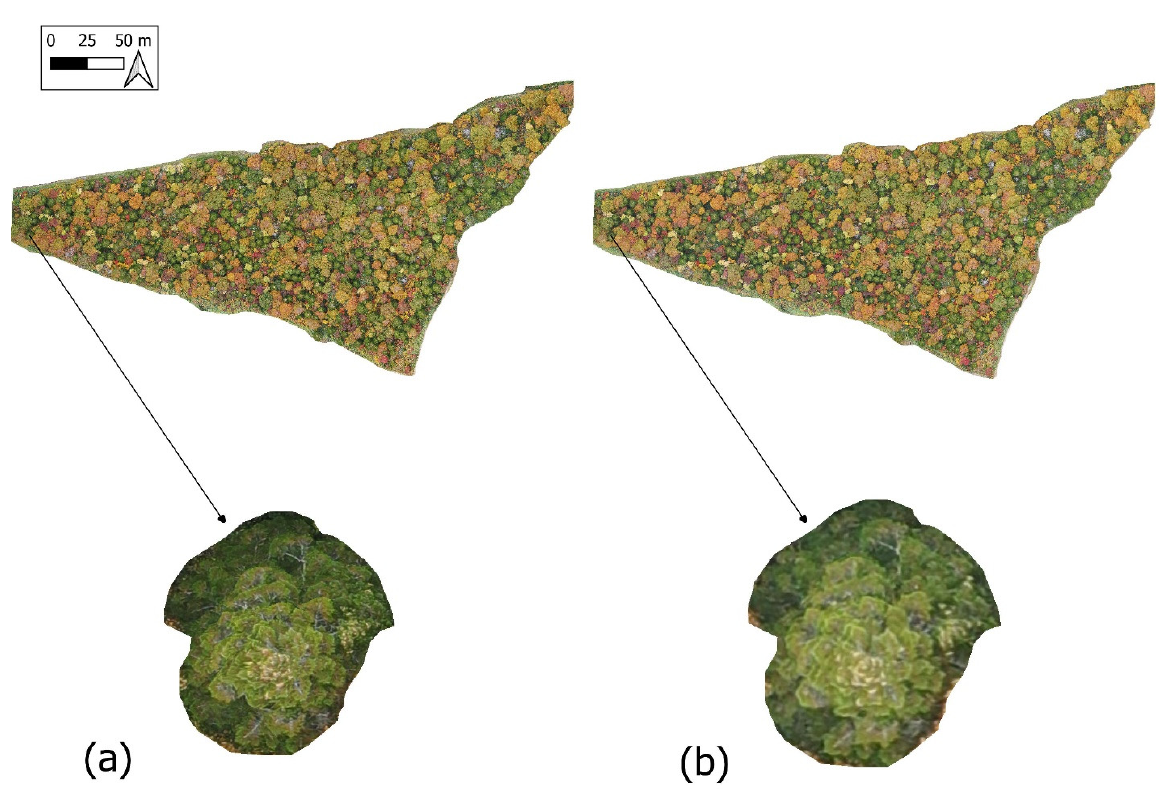
Figure 7. Regions of interest and fir tree canopy difference in the bottom area of the orthomosaic: ( a ) when using the TAF, the lower branches and the shape are clearer, and ( b ) when not, fewer details are visible.